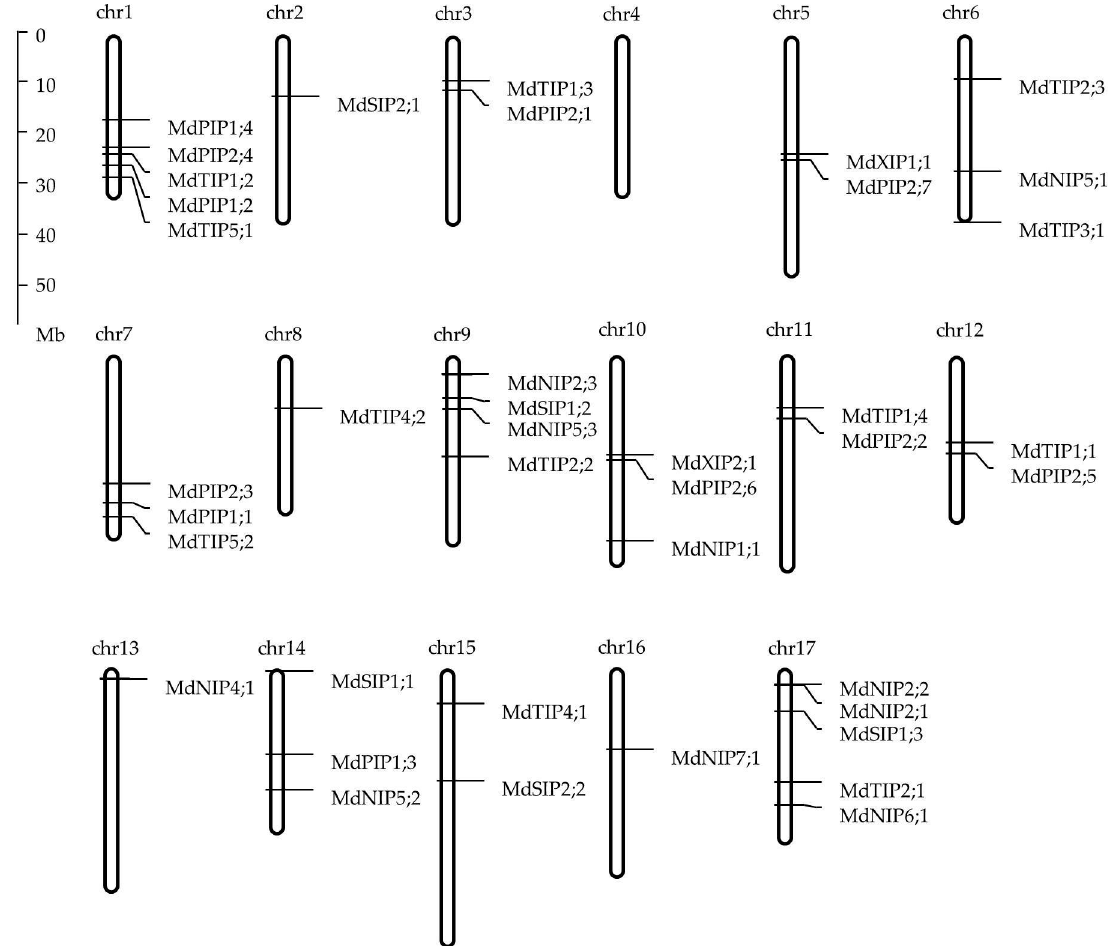
Figure 2. Distribution of AQP genes in apple chromosomes. Two genes ( MdNIP1;2 and MdTIP3;2 ) could not be localized on any chromosome. The scale is in megabases (Mb).